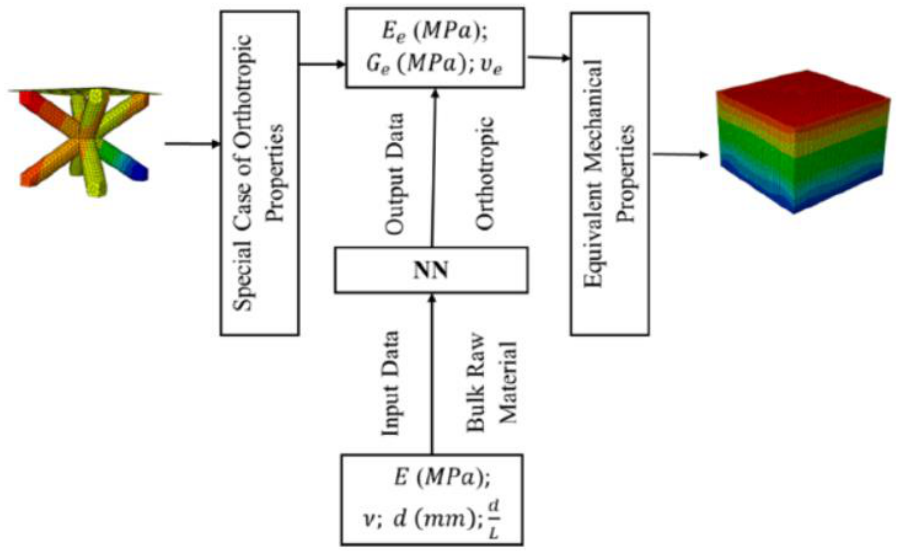
Figure 10. Integration of FEA model to NN model [42].